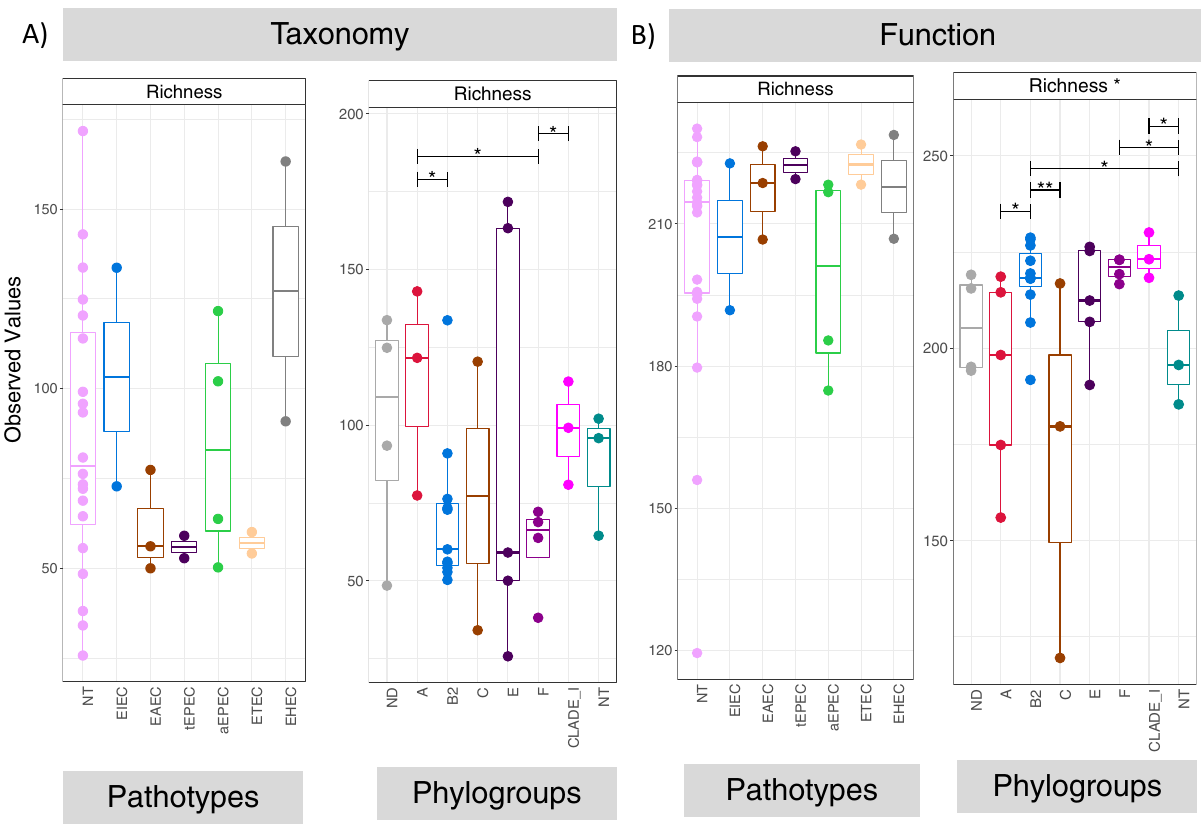
Figure 2. Rarefied Richness estimates for OTU abundance table ( A ), and for recovered MetaCyc pathways ( B ), with samples organized under a given convention, whether it is pathotypes or phylogroups. Two groups are connected together with a line if the ANOVA values are